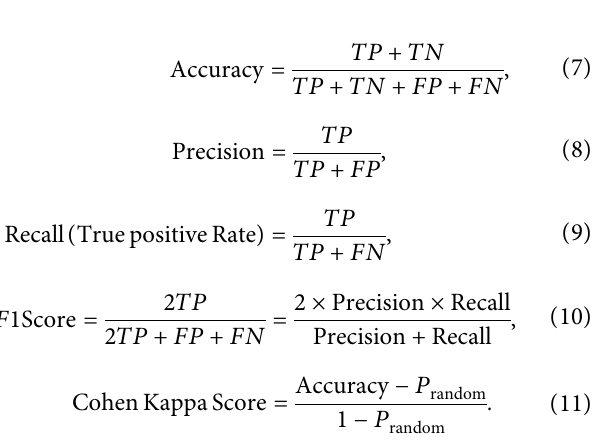
Figure 8: Functionality of intelligent